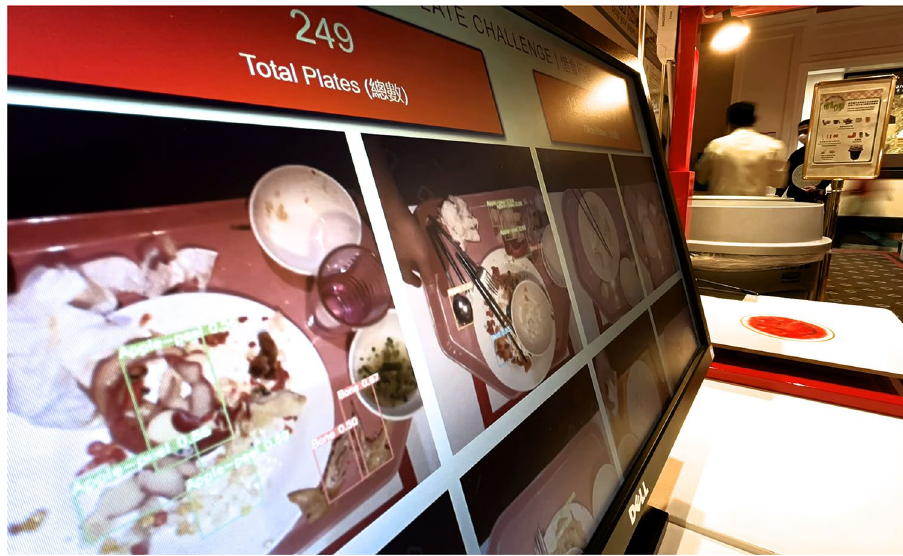
Figure 13. Clean plate challenge real-time display. It shows a live count of the total number of plates, the number of clean plates (with percentage to target) and the images of trays with bounding boxes